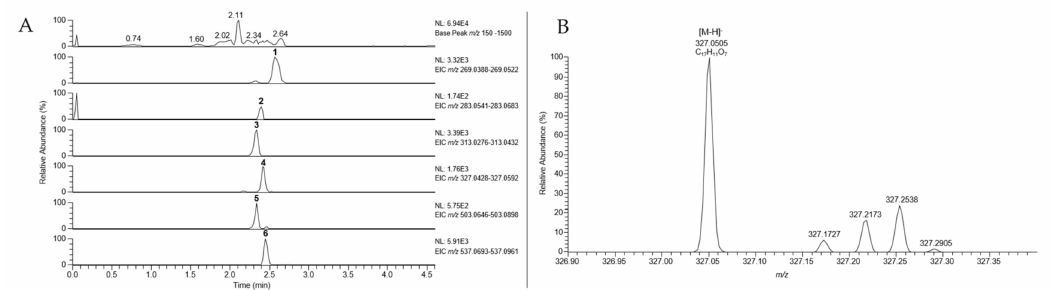
Figure 3. ( A ) Extracted ion chromatograms (EIC, mass window: 25 ppm) of anthraquinones 1-6 from crude extract of Cortinarius (D.) austronanceiensis , ( B ) Extracted ion chromatogram (EIC) of